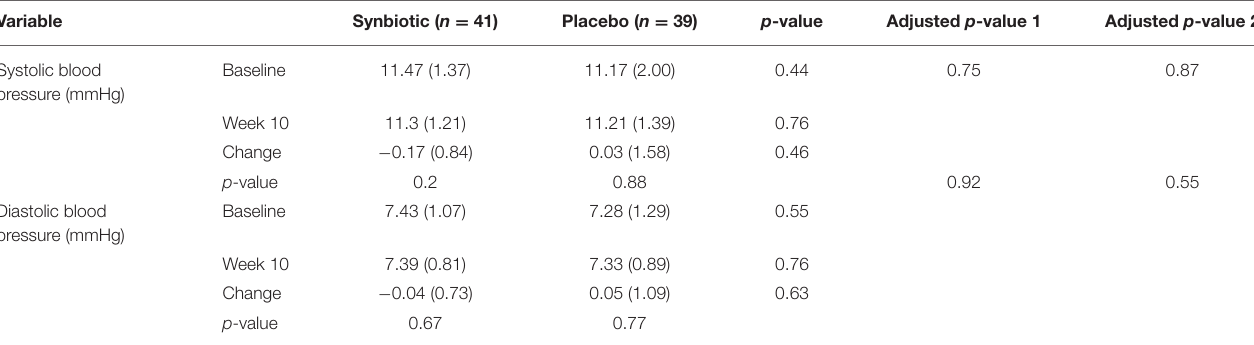
TABLE 4 | Findings related to blood pressure at baseline, at the end of the study and changes between the synbiotic and placebo groups.